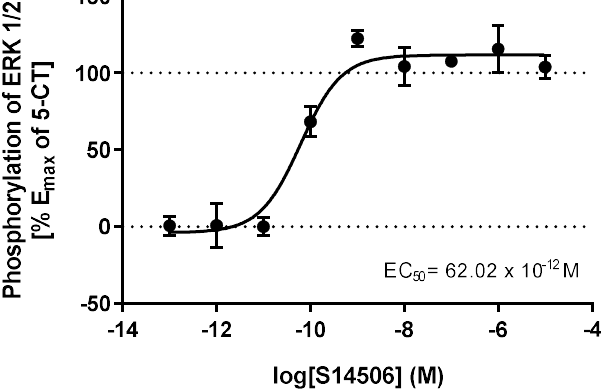
Figure 5. Influence of S14506 on the (1 µ M) forskolin-stimulated cAMP level in HEK293 cells that overexpress the 5-HT1AR gene.